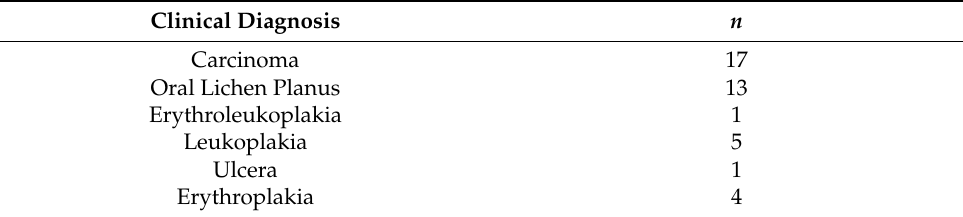
Table 4. Provisional clinical diagnosis ( n =